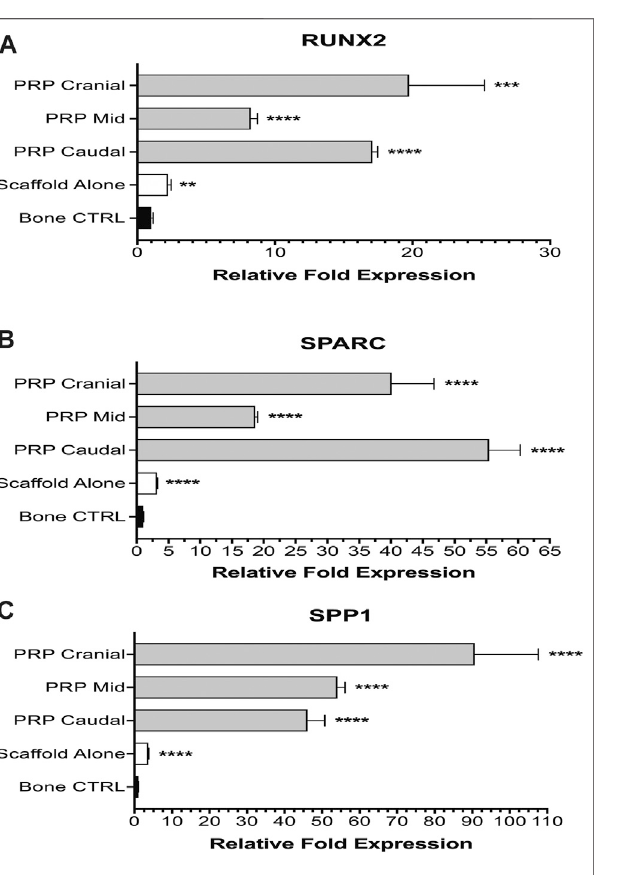
Frontiers in Bioengineering and Biotechnology |